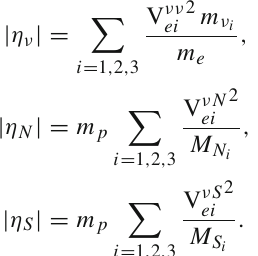
Using Tables 4 and 5, one can derive theoretical limits on effective Majorana mass which we use in our numerical esti- mations to derive limits on absolute value of light neutrino masses.